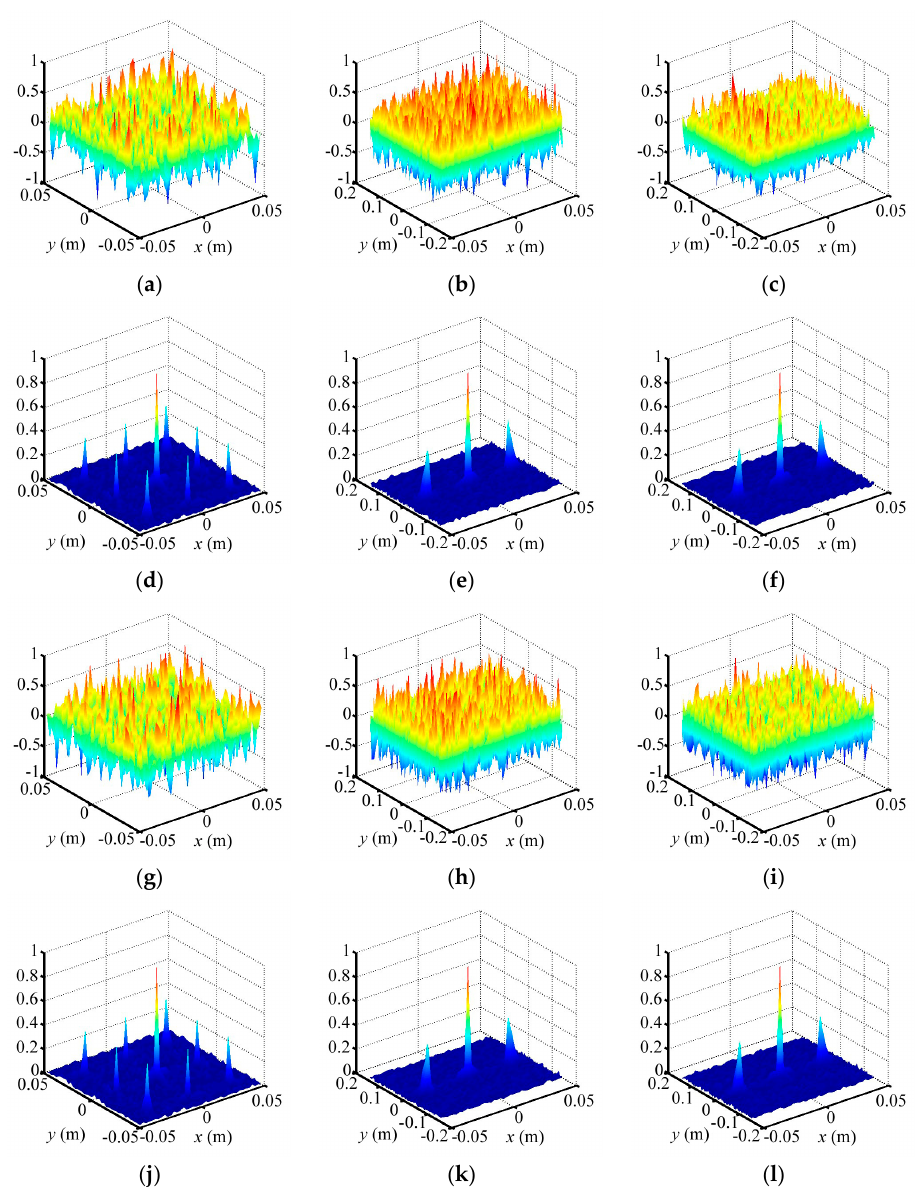
Figure 7. ( a – c ) Radiation field distributions for SIMO TCAI corresponding to xoy , xoz , and yoz , respectively; ( d – f ) Space independence functions for SIMO TCAI corresponding to xoy , xoz , and yoz , respectively; ( g – i ) Radiation field distributions for SISO TCAI corresponding to xoy , xoz , and yoz , respectively; ( j – l ) Space independence functions for SISO TCAI corresponding to xoy , xoz , and yoz , respectively.